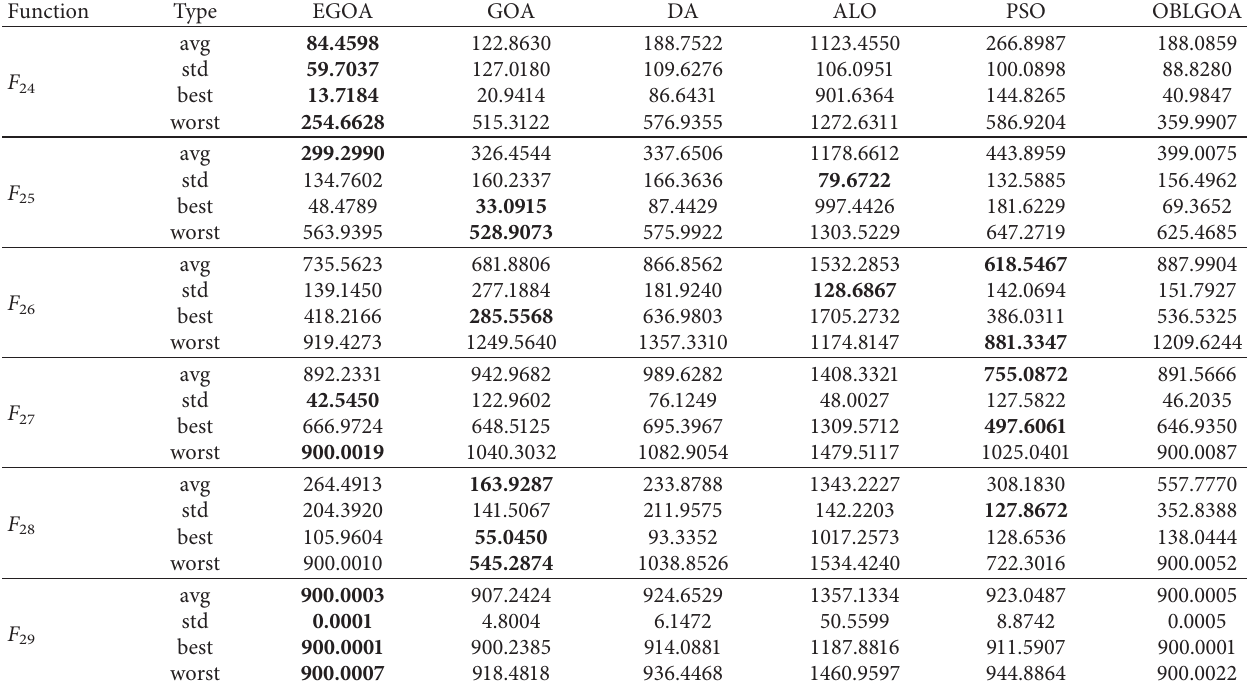
Table 7: Results for composite